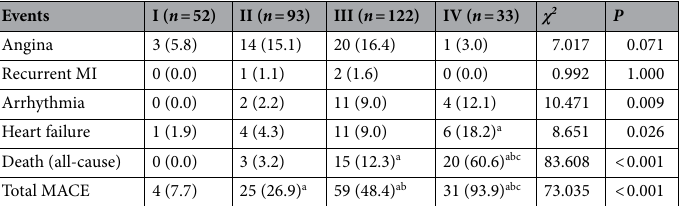
Table 4. Incidence of MACEs in patients with different grades [ n (%)]. a vs. Grade I, b vs. Grade II, c vs. Grade III, P < 0.05. MI myocardial infarction, MACE major adverse cardiovascular events.